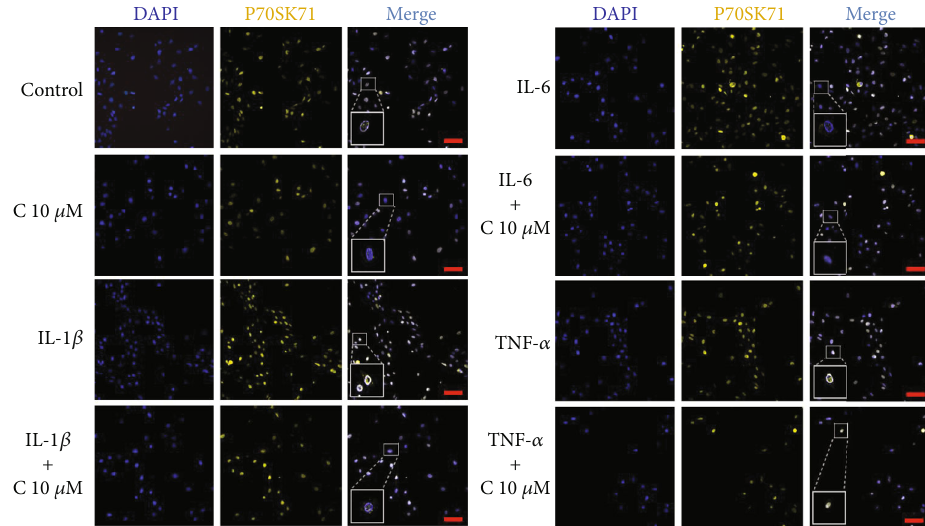
Figure 5: Representative images of subcellular localization of the P70SK61 protein in SW982 cells after 24 h incubation with curcumin (10 μ M) and cytokines (50 ng/ml). The photographs were taken on a Zeiss Cell Observer SD confocal microscope. Scale bar = 100 μ m.